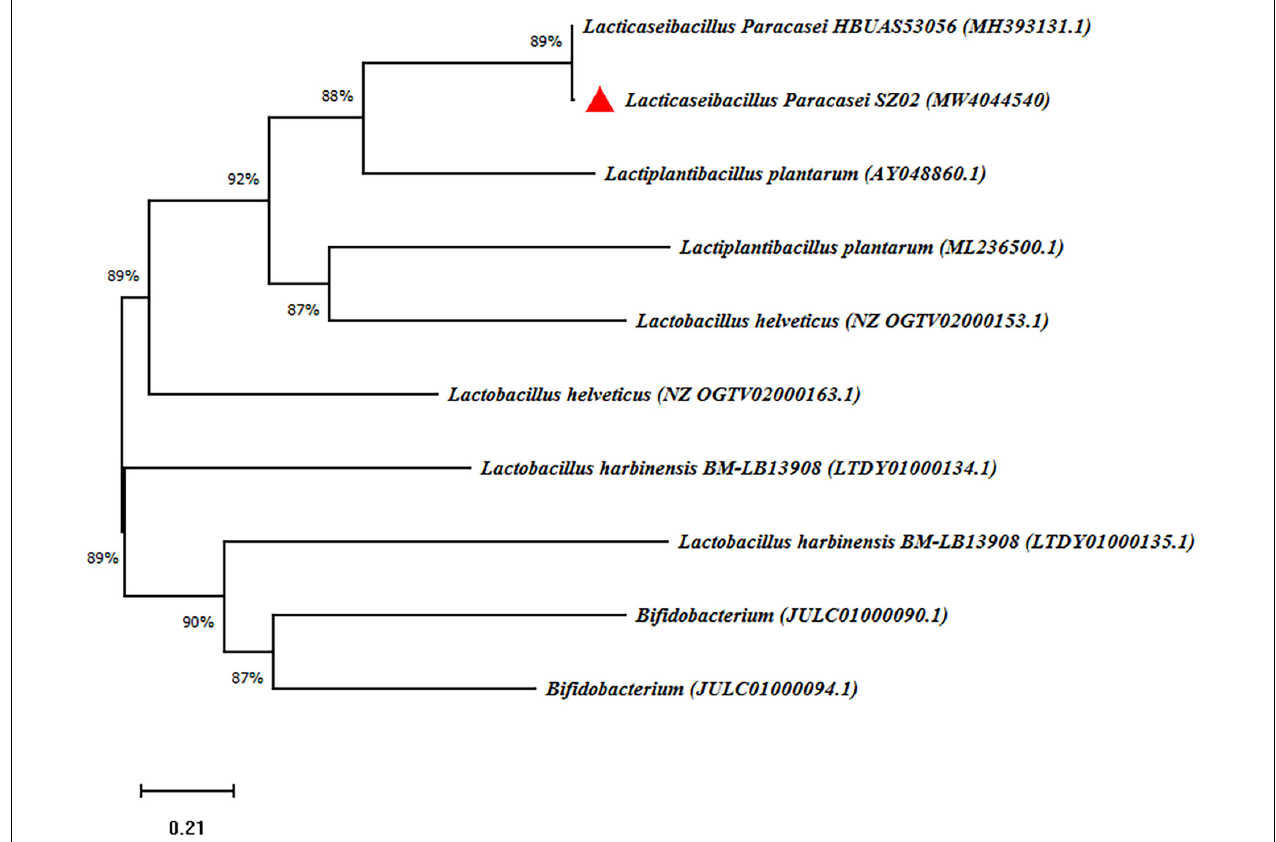
FIGURE 7 | Phylogenetic relationship of SZ02 with related species based on partial 16S rDNA gene sequence analysis. The phylogenetic tree was constructed using the neighbor-joining method (MEGA-X). The numbers at the nodes are bootstrap confidence levels (percentage) from 1,000 replicates. The scale bar represents 0.05 substitutions per nucleotide position. Reference sequences were obtained from the GenBank nucleotide sequence database. TABLE 2 | pH, titratable acidity, and chemical composition of sour porridge. Sample Acid liquid Broomcorn millet Crude protein Crude